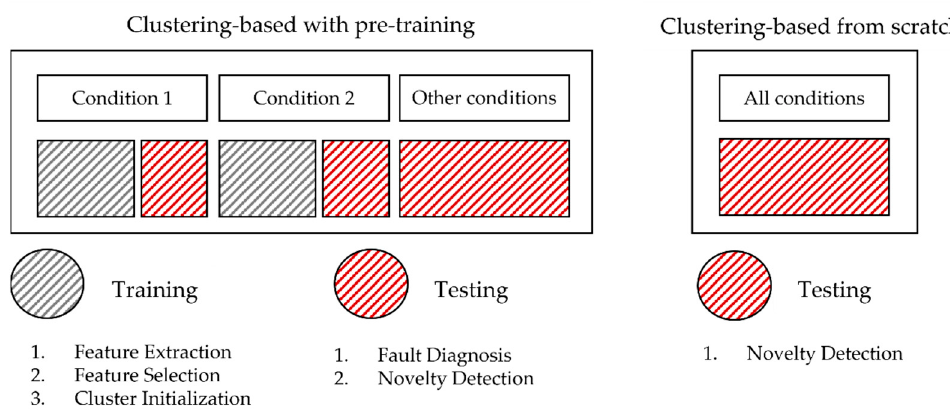
Figure 6. Experimental scenario.